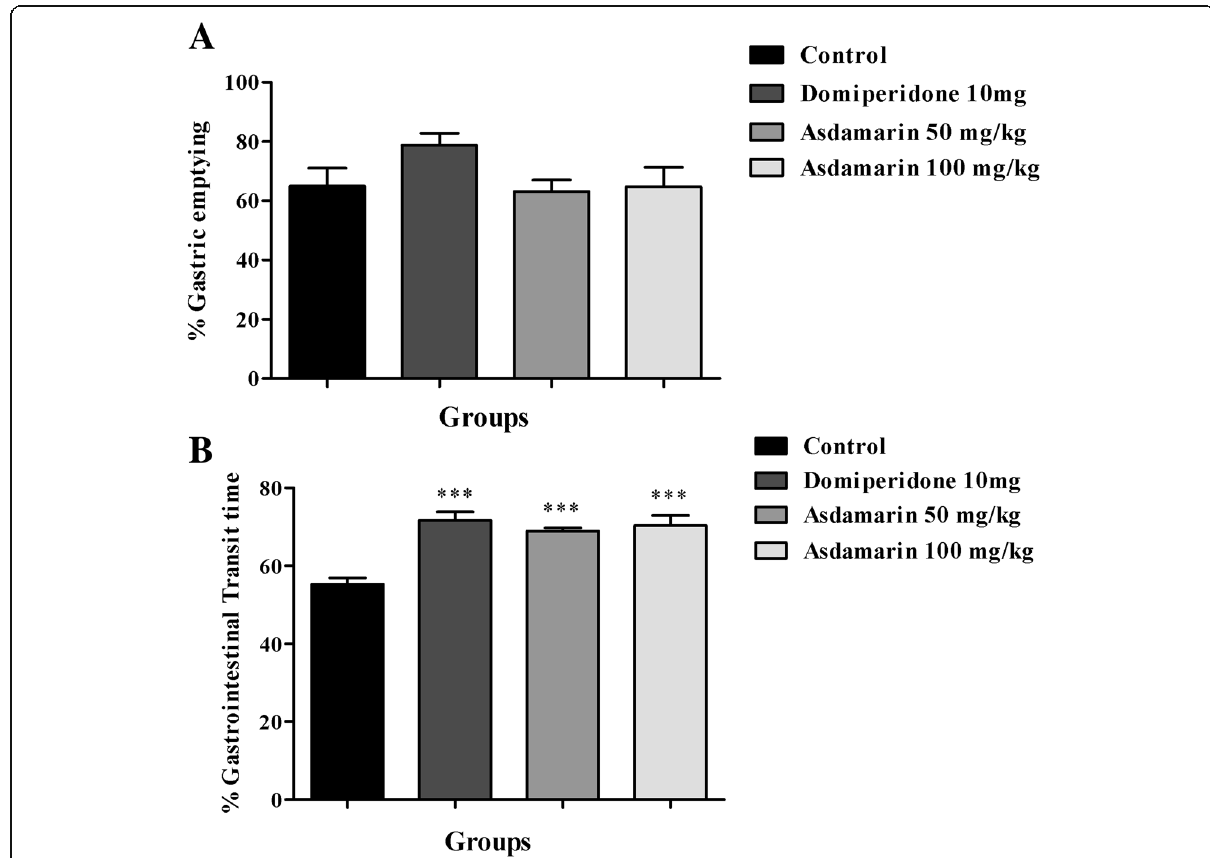
Fig. 2 Effect of Asdamarin on ( a ) gastric emptying and ( b ) percentage gastrointestinal transit time (GIT) in SD rats. Values are expressed as mean ± SEM ( n = 6). Data were analyzed by one way ANOVA followed by Dunnet ’ s t test. *** p < 0.001 compared to control